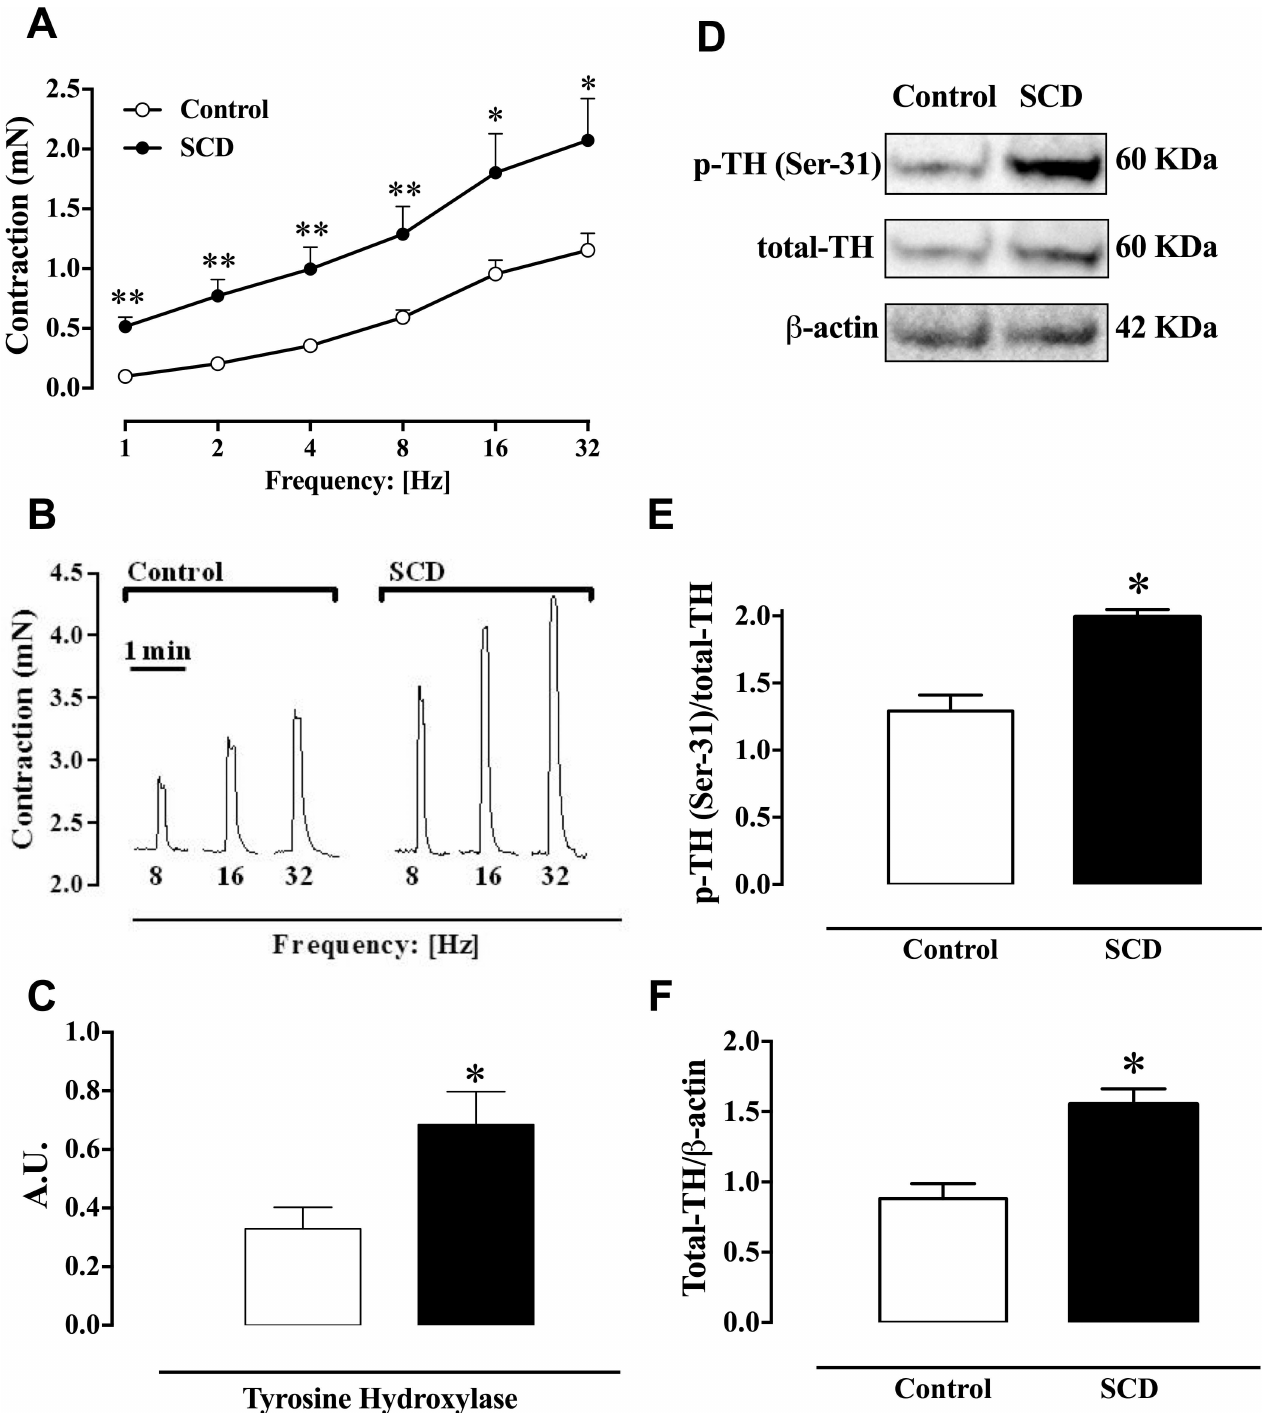
Fig 1. ( A ) Contractileresponsesto EFS (1–32 Hz) and ( B ) representative tracings of contractileresponse to EFS in corpus cavernosumstrips from control and SCD mice. Data are shown in mN, and represent the mean ± SEM of 5 to 6 mice in each group. ( C ) mRNA expressionof tyrosine hydroxylase in the homogenates of corpus cavernosumfrom control and SCD mice. ( D ) Representative blotting densitometric of tyrosine hydroxylase (TH) phosphorylated at Ser 31 (p-TH), total TH and β -actin in the homogenates of corpus cavernosumfrom control and SCD mice detected by Western blotting. Protein values for ( E ) p-TH/total TH and ( F ) total TH/ β -actin. Data represent the mean ± SEM of 4–5 mice in each group. Single asterisk indicates p < 0.05 vs control group. Doubleasterisks indicate p < 0.01 vs control group. (Student’sunpaired t -test).